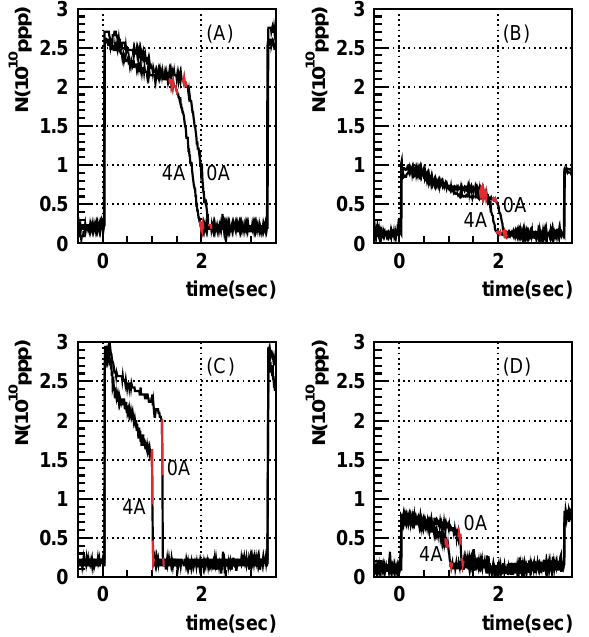
FIG. 5. (Color) Typical beam loss waveforms when the reso- nance line was crossed (A),(B) downward or (C),(D) upward. The initial beam intensity was decreased with an attenuator in cases (B) and (D). The data for I QDS (cid:1) 0 A and 4 A are shown. The red parts of each waveform define the tunes where beam loss occurred and was finished.